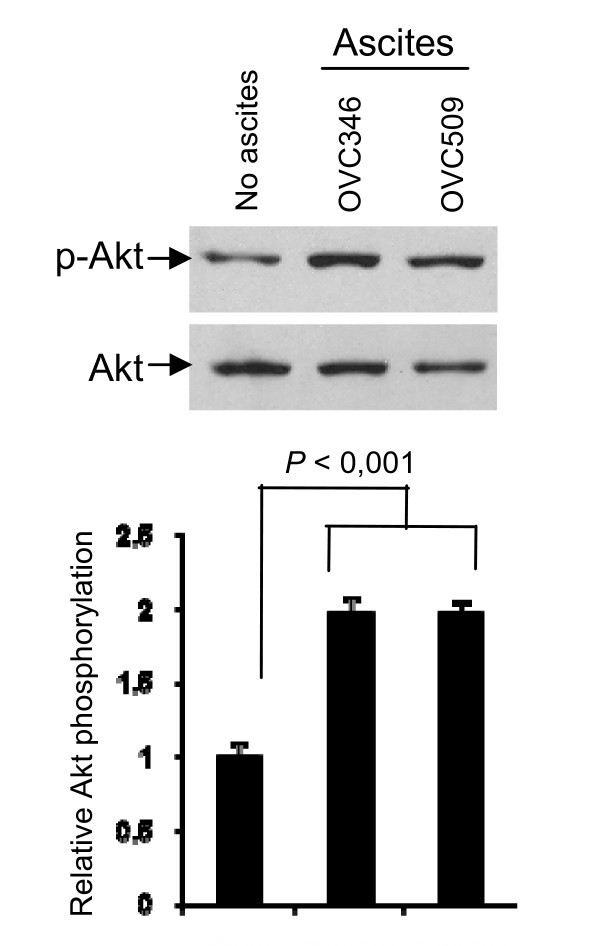
Ovarian cancer ascites OVC346 and OVC509 were incubated with primary cultures from sample 346A for 90 min. Lysates were obtained and Western blot analysis was performed with phospho-Ser473 Akt (p-Akt) and Akt antibody (Akt). Densitometric quantification of phosphorylated Akt from three separate experiments normalized to total Akt. Data are expressed as Akt phosphorylation fold increased relative to 349A cells not treated with ascites.